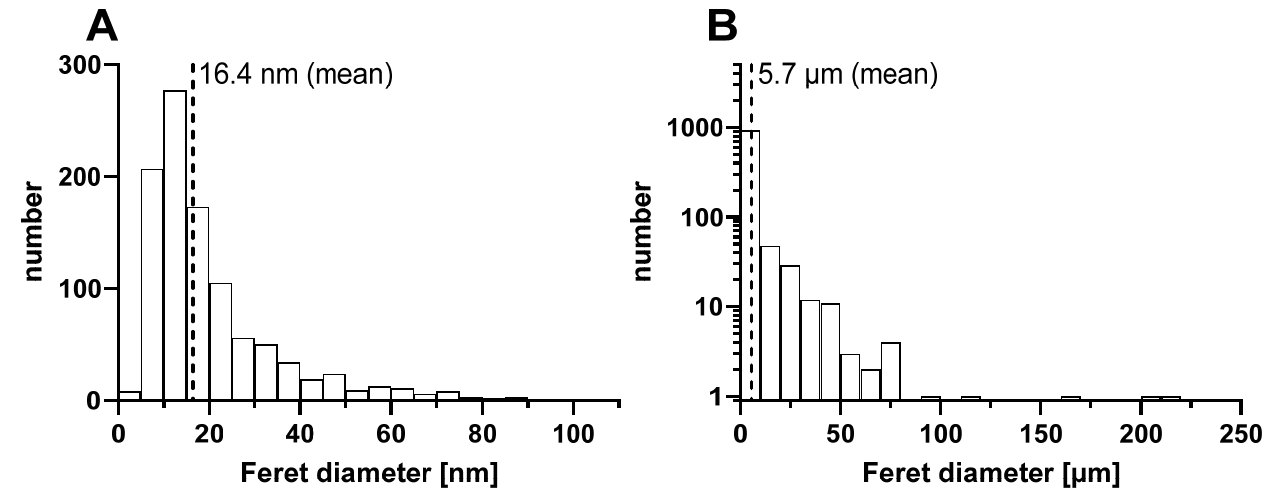
Figure 1. ( A ) Particle size distribution of laser-generated colloidal PET nanoparticles determined by TEM analysis (1011 particles were analyzed). ( B ) Particle size distribution of PET microparticles determined by light microscopy at a magnification of 5× (1050 particles were analyzed).